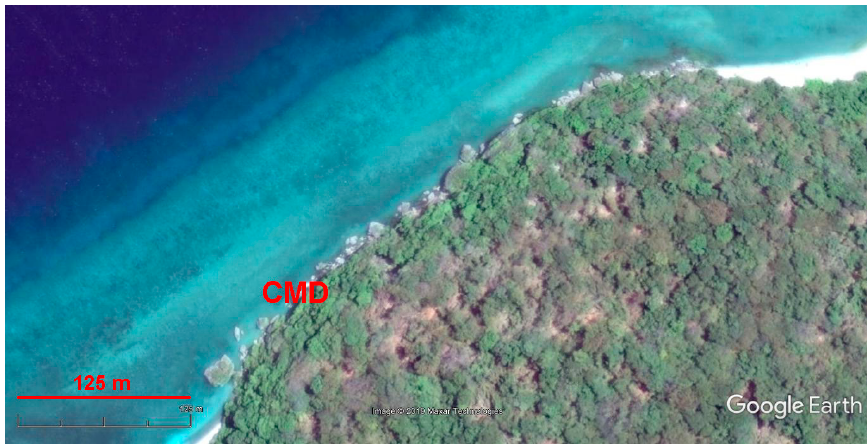
Figure 7. The northeastern plot of the Wetar Island locality (the view provided by the Google Earth Engine).